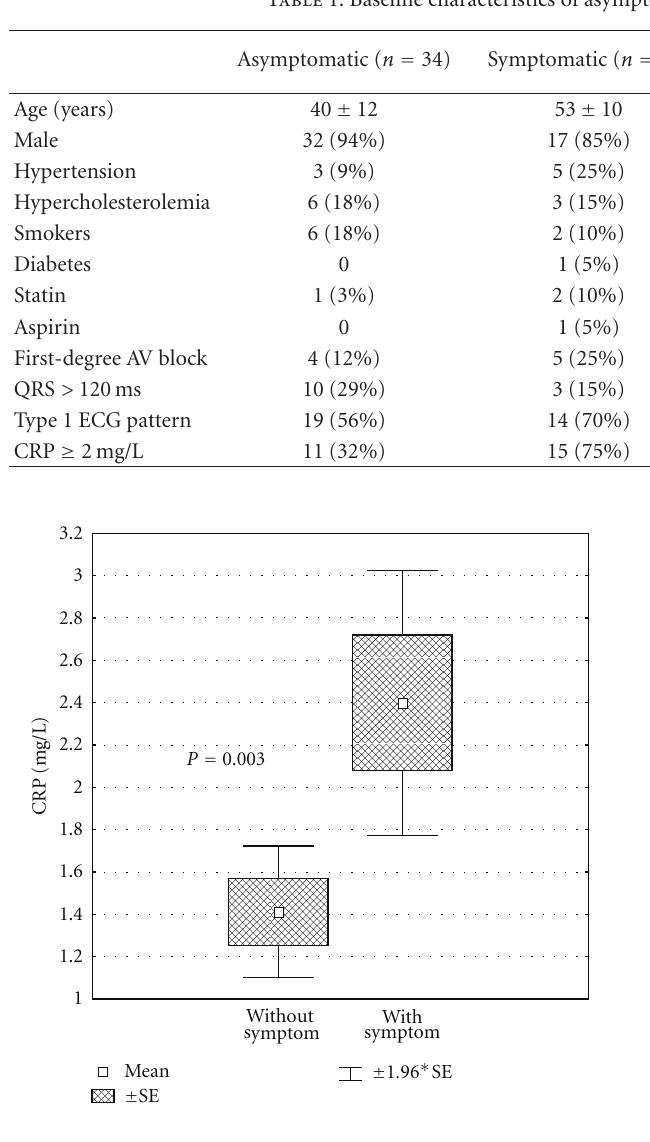
Figure 2: CRP concentrations in the BrS patients without (left diagram) and with (right diagram) symptoms (syncope or SCA) were significantly di ff erent. CRP: C-reactive protein; BrS: Brugada syndrome; SCA: sudden cardiac